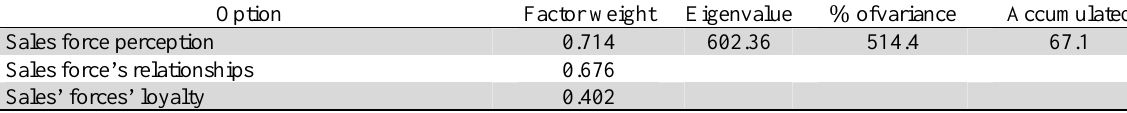
The summary of factors associated with sales force’s personality